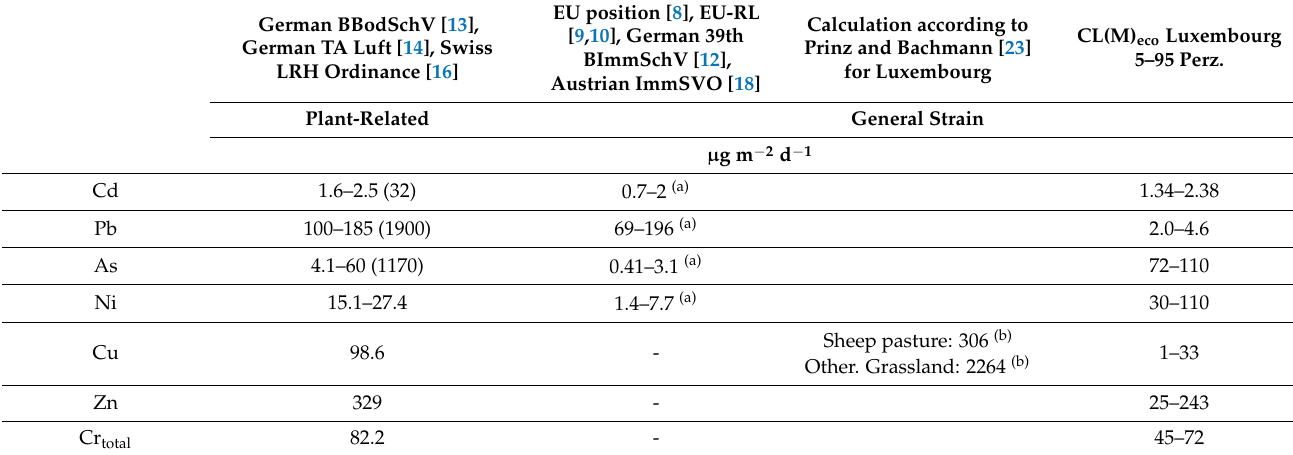
Table 21. Assessment values for the protection of arable, grassland, deciduous, and coniferous forest ecosystems. German BBodSchV [13], German TA Luft [14],